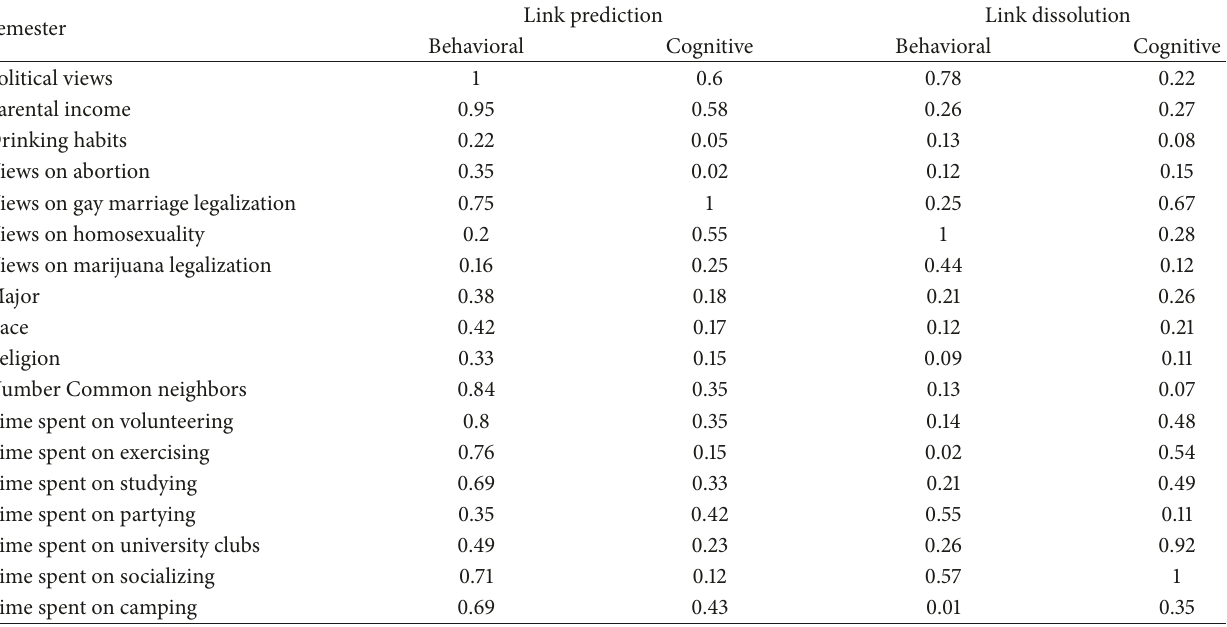
Table 4: Weights of different attributes.